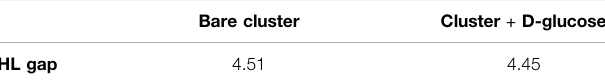
TABLE7| HOMOLUMOgapenergies(HLgap)calculatedatB3LYP-D3BJforthe clustermodelsofbothbare(100)TiO 2 surfaceandadsorbed D -glucoseinO1- center mode. All the energies are given in